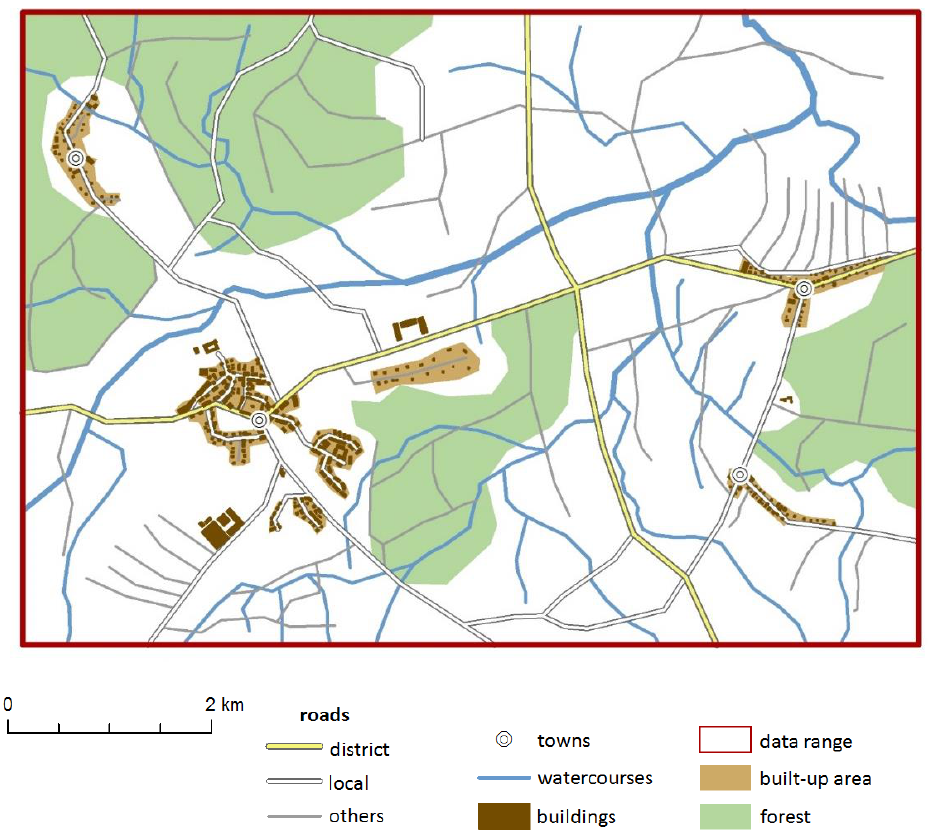
Figure 2. Model data in the area A shown in Figure 1 (viewed in ArcMap ESRI); source: own work.